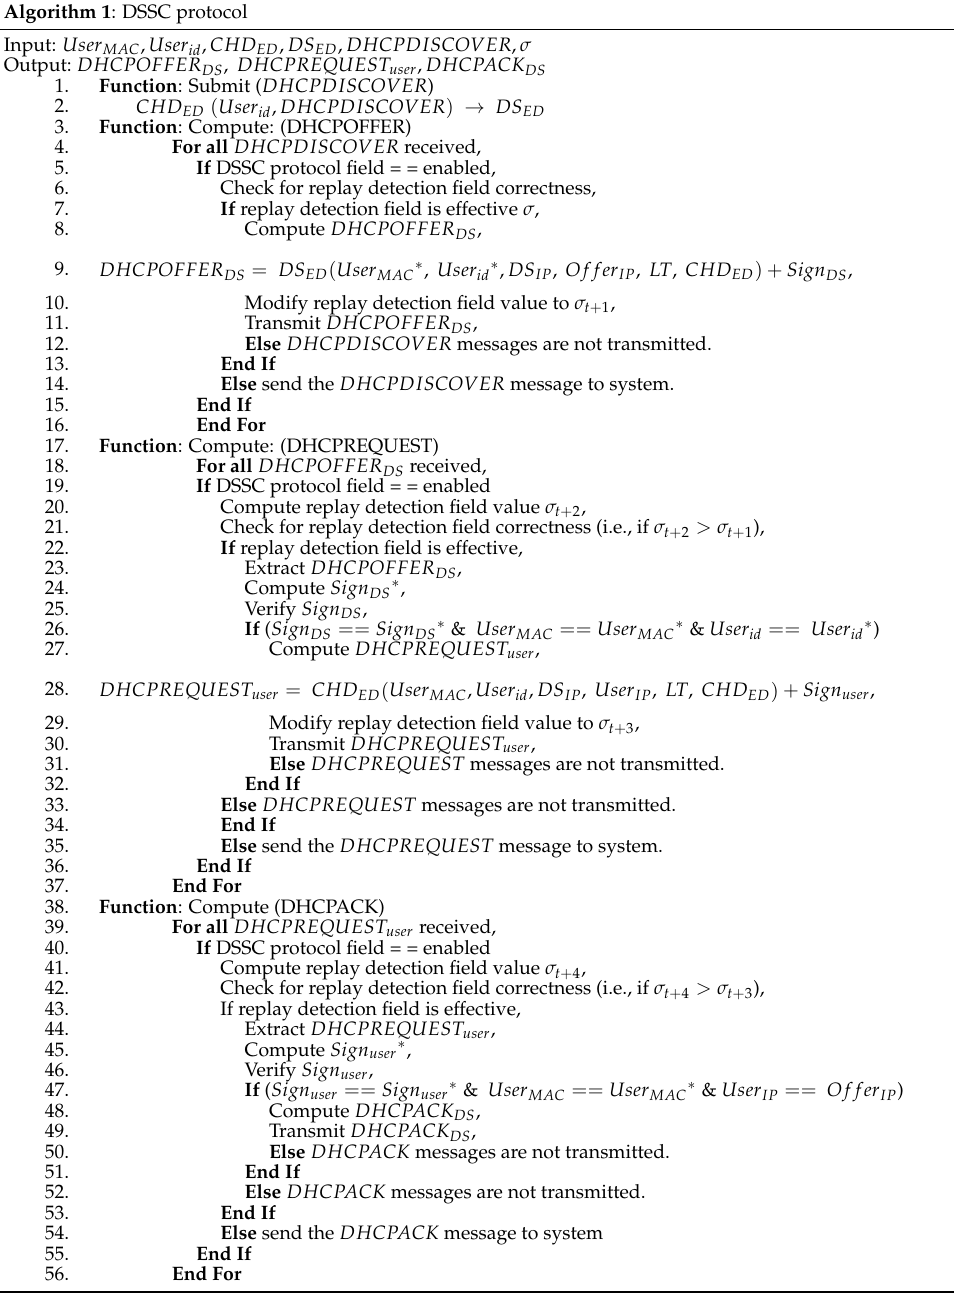
Algorithm 1 : DSSC